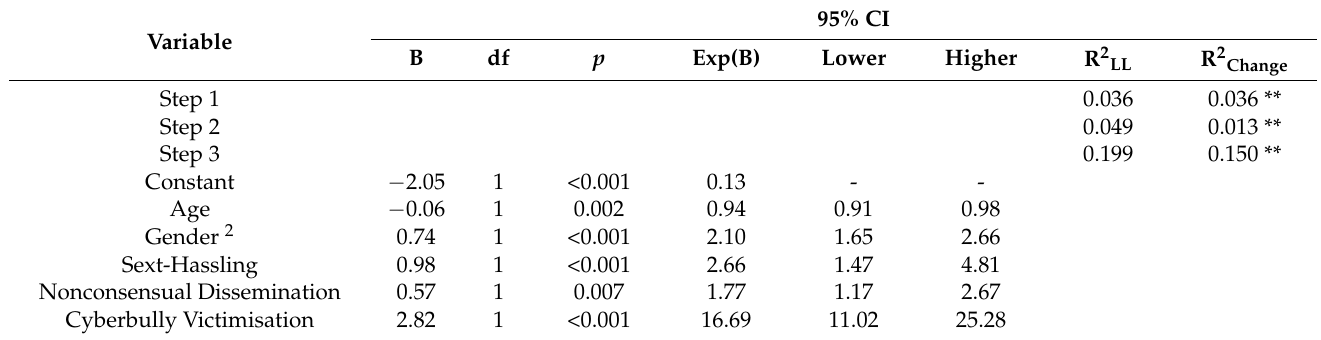
Table 3. Logistic Regression Results Regarding Cyberbully Perpetration 1